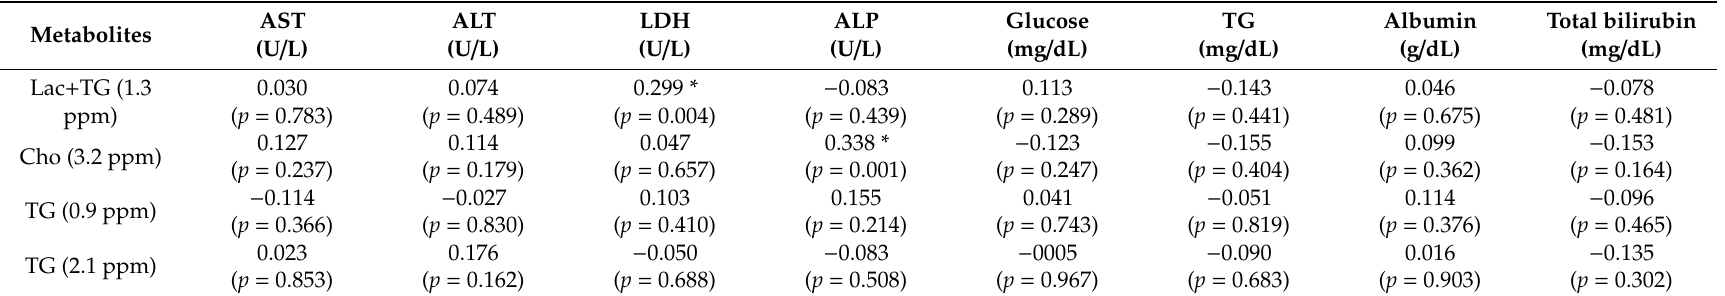
0.023 0.176 TG (2.1 ppm) ( p = 0.853) ( p = 0.162) ( p = 0.683)